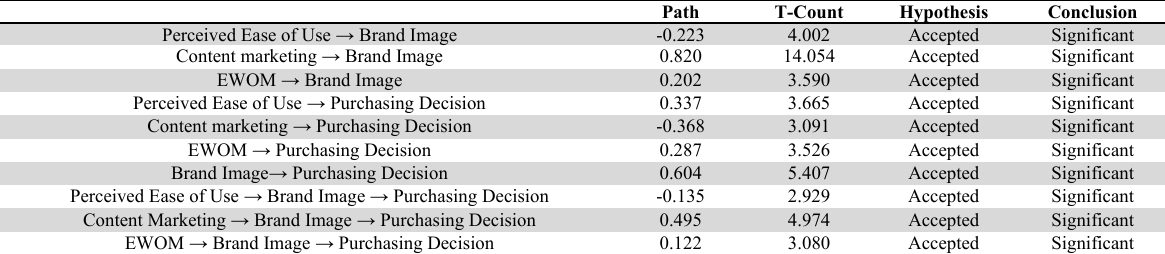
Results of Hypotheses